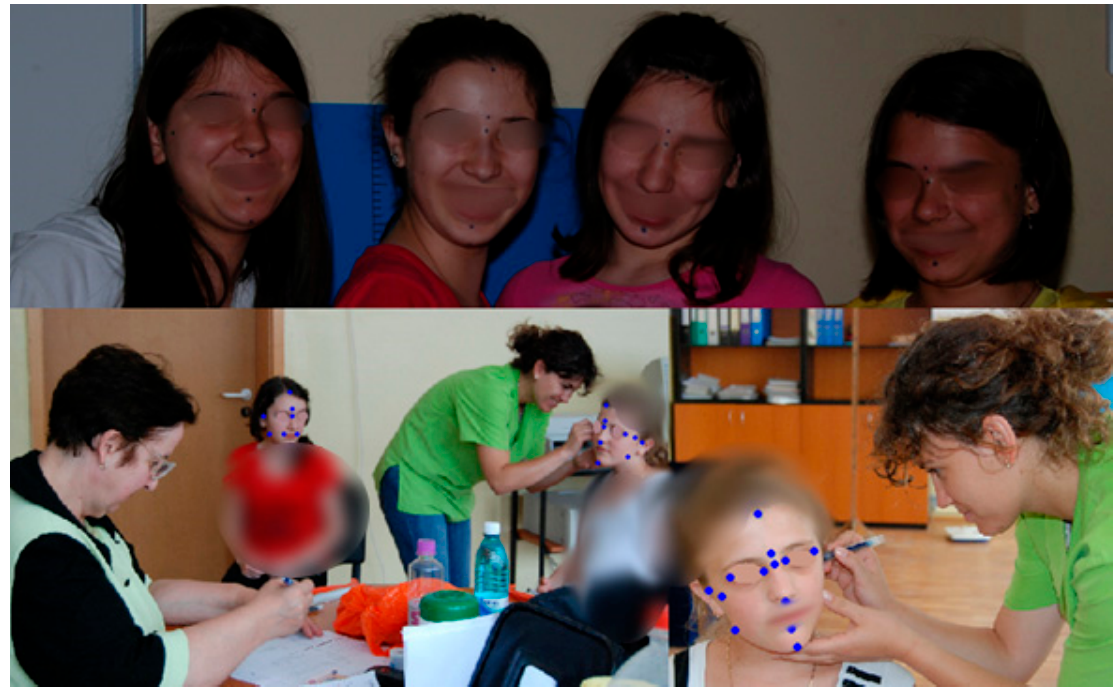
Figure 3. Marking of the median and lateral selected anthropometric reference points. The selected transversal measurements are eight: Zygomatic width (maximal facial width; Zy-Zy); Gonial width (maximal mandibular width; Go-Go); Mouth width (maxi- mal mouth width, measured from one mouth angle to the other; Ch-Ch), Nose width (maximal nose width; Al-Al); Nose basal width (En-En); the distance between the outer commissures of the eye fissures Ex-Ex); the distance between the N point and the middle of the left pupil; and, the width of the head between Tragus (Tr-Tr) [1,6,38]. The selected vertical measurements are 12, namely: Face height (N-Gn), upper face height (N-Sn), N-Sto, lower facial segment height (Sn-Gn), the height of both lower face segments, situated upper and lower to Sto (Sn-Sto and Sto-Gn), upper lip height (Sto-Ls) and lower lip height (Sto-Li), two segments of Sto-Gn, situated upper and lower to Sl (Sto- Sl and Sl-Gn), G-Sn, and Tri-Sn. The selected sagittal measurements are three: superior facial depth (Tr-N), middle facial depth (Tr-Sn), and lower facial depth (Tr-Gn). The values that were obtained by measurements, as done in the three spatial planes, were used for determining the reference values for different dimensions and different ages. 2.4. Sample Description, Study Protocol and Data Analysis Our sample included 85 children and adolescents, from one nursery school and two schools, from Timisoara city and surroundings, Romania country. Fifty-three (62%) were girls and 32 boys (38%), aged between 3.5 and 14.5 years (Table 1). The sample was best represented for the groups that were included in 11.5–14.5-year intervals. For the sample size calculation, we conducted a power analysis test with GPower3.1 application using the medium effect size, 0.05 level of significance, and 80% power. The sample is representative, because it respects the proportions of age groups and categories according to BMI in the population (underweight 10.9%, normal weight 72.7%, overweight 10.9%, and obese 5.5%). The time that is needed for each child measurement was 20 min., with the exception of the children aged between 3.5 and 6.5 years; in the last cases, the time was increased according to the ability to cooperate with each child.